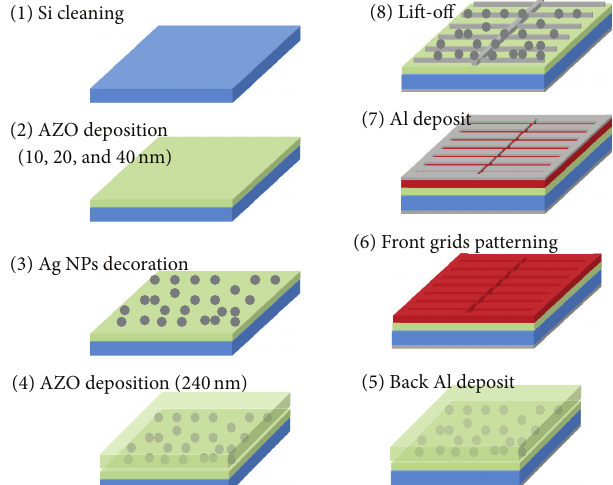
Figure 9: Schematic fabrication process of AZO/Ag NPs/AZO/Si solar cell structure with front and back contacts of Al [32].